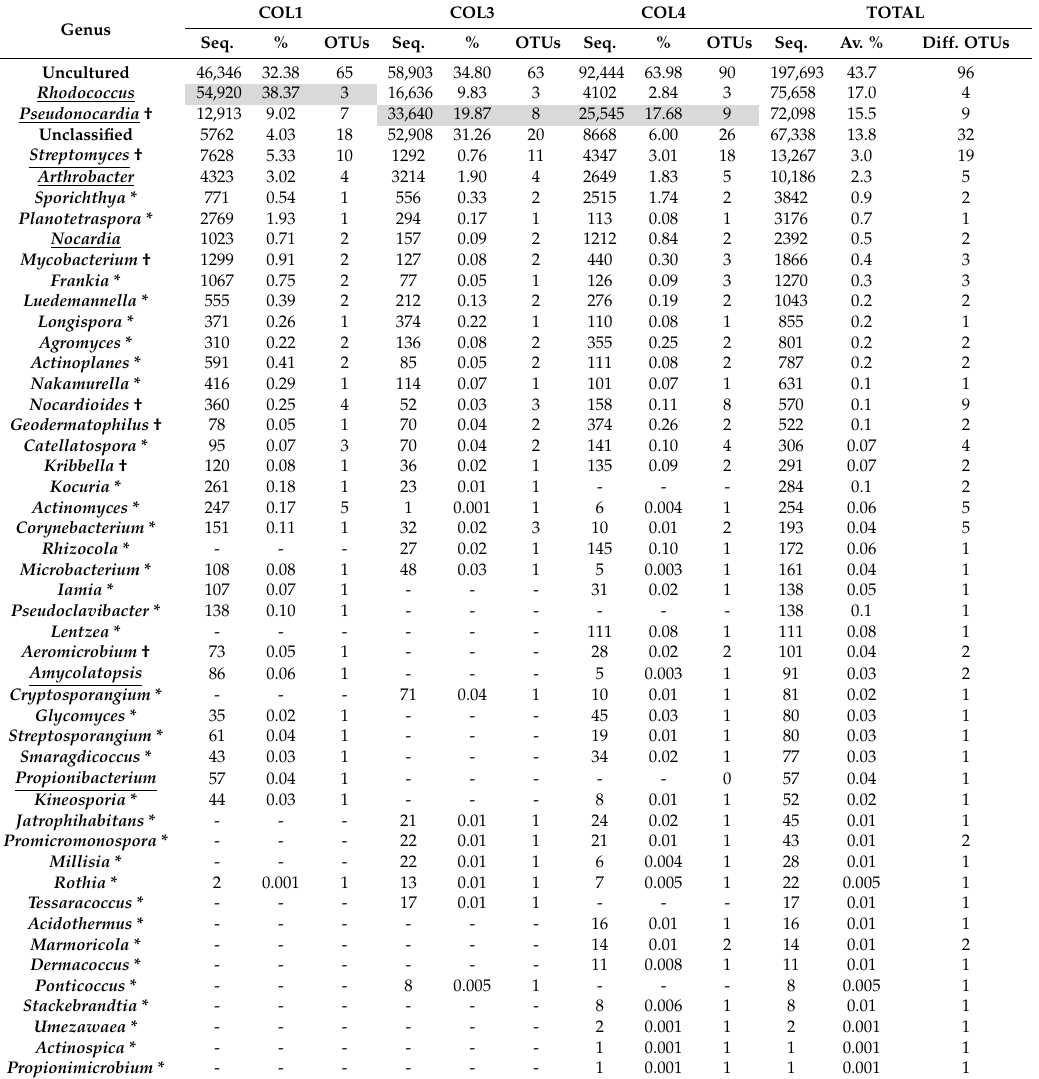
Table 3. Actinobacterial genera pattern in moonmilk deposits of the “Grotte des Collemboles” based on 16S rRNA amplicon